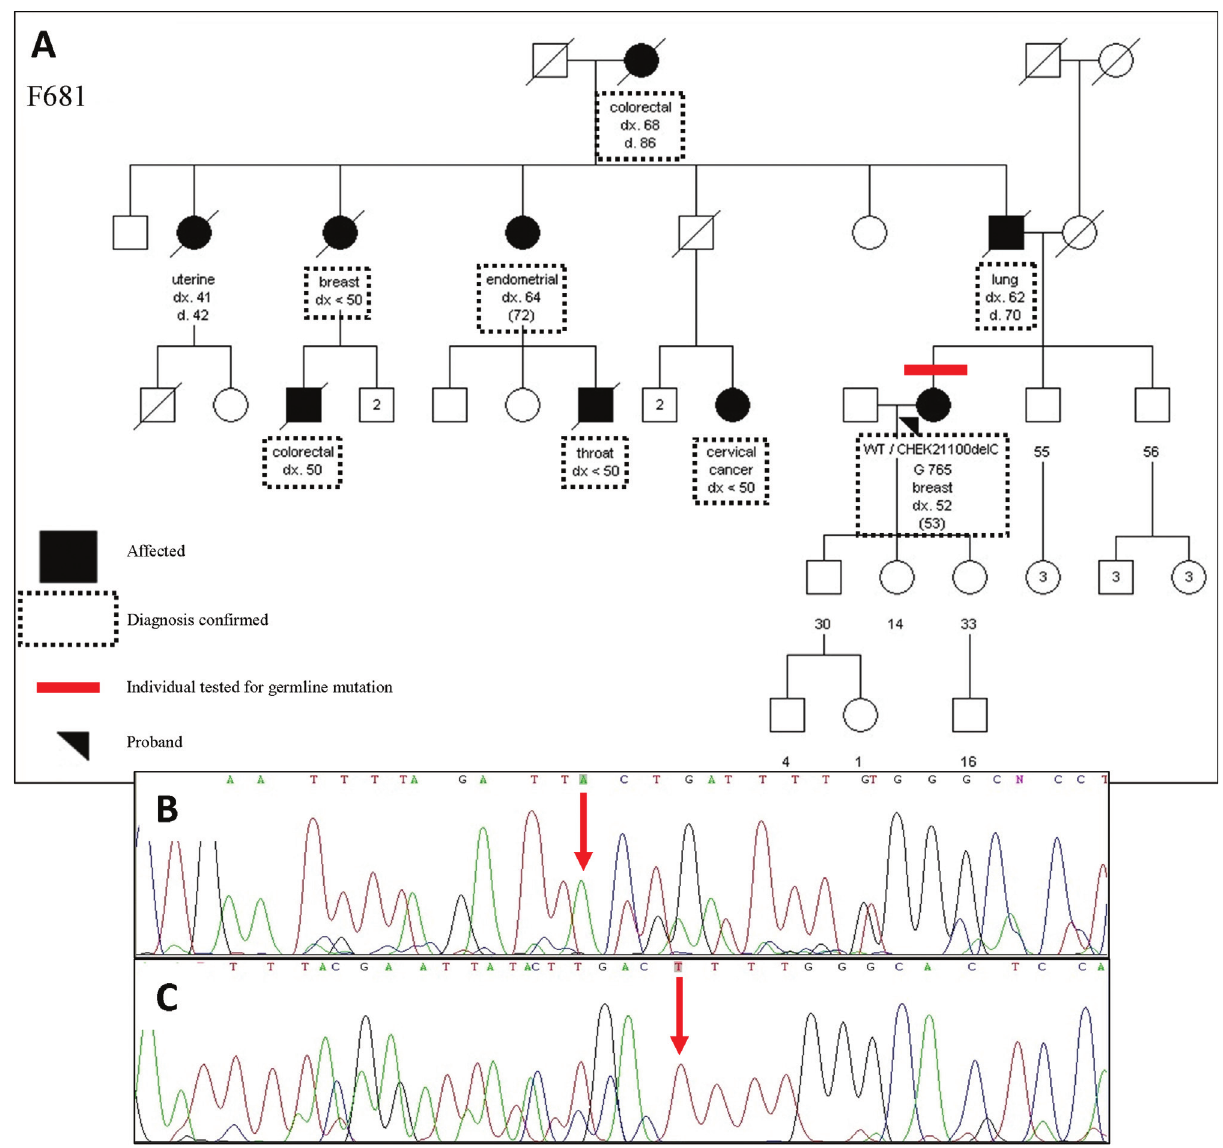
Figure2 - CHEK2 1100delCmutationfamily.Pedigree(A),forward(B)andreverse(C)sequencingofgermlineDNA.WT=wildtype;dx=ageatdiagno- sis; d=age of death; red arrows indicate the last readable